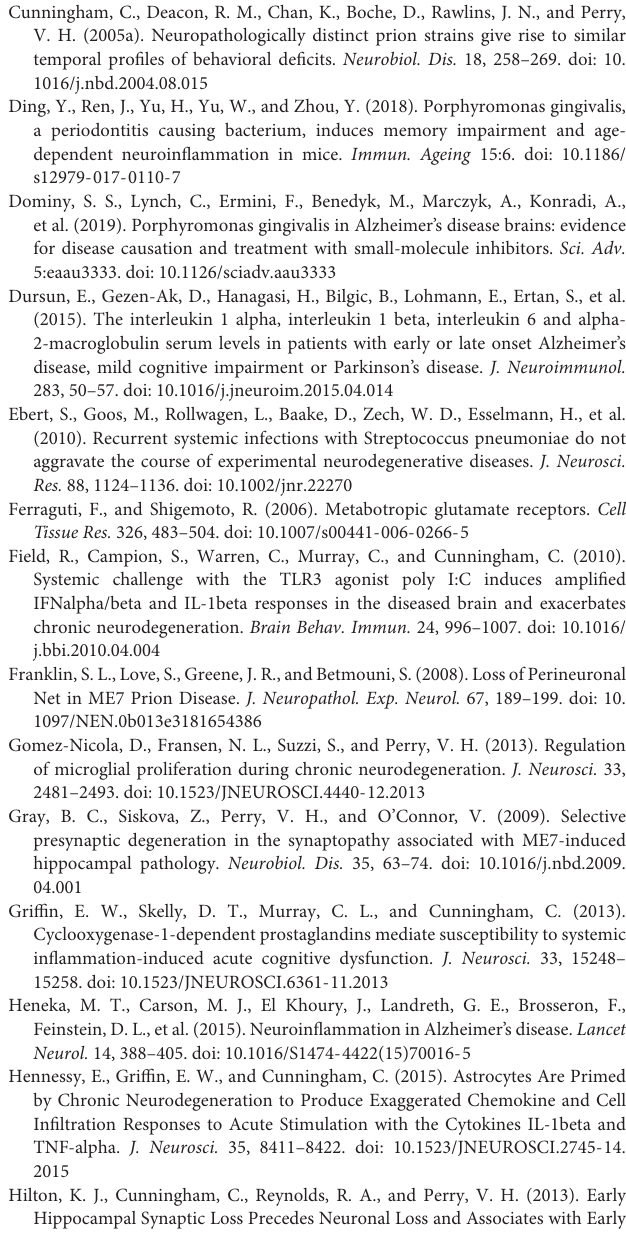
Supplementary Figure 1 | Body weight changes following systemic infection with S. typhimurium. ME7 prion mice received an i.p injection of with saline (closed squares) or 1 × 10 6 colony forming units S. typhimurium SL3261 (open squares) at 8 weeks after ME7 inoculation and body weight of mice was monitored for 4 weeks. NBH-injected mice (closed circles) were included as control. ∗∗∗ p < 0.001 between ME7 + SL3261 and NBH mice at 1-day post-infection; n = 4–5/group plotted as mean ±